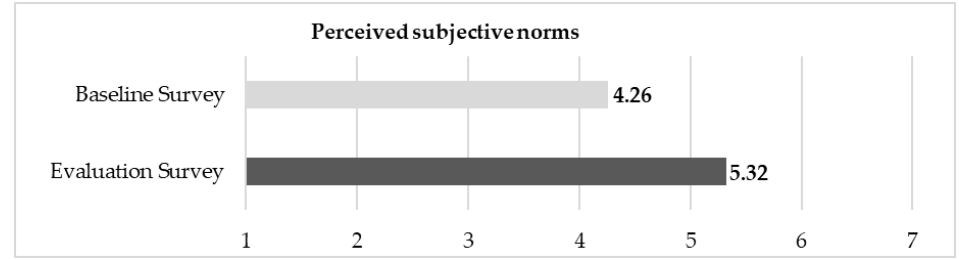
Figure 5. A comparison of perceived subjective norms in Greek public buildings (before and after the trial).